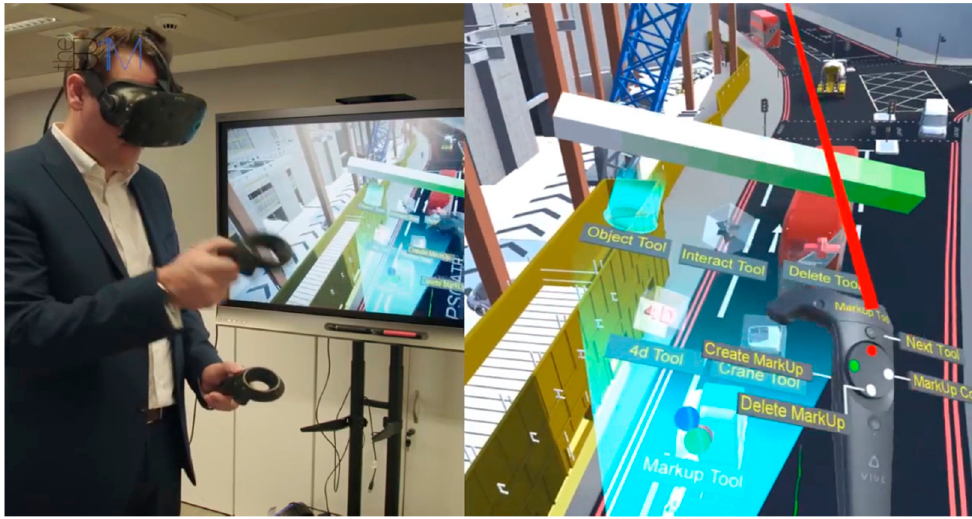
Figure 4. Interactive features allow construction team members to plan and review site logistics and construction sequence while changing the viewing scale (Source: